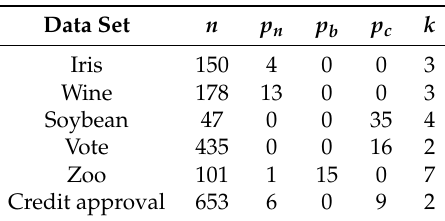
Table 3. Details of the real datasets.